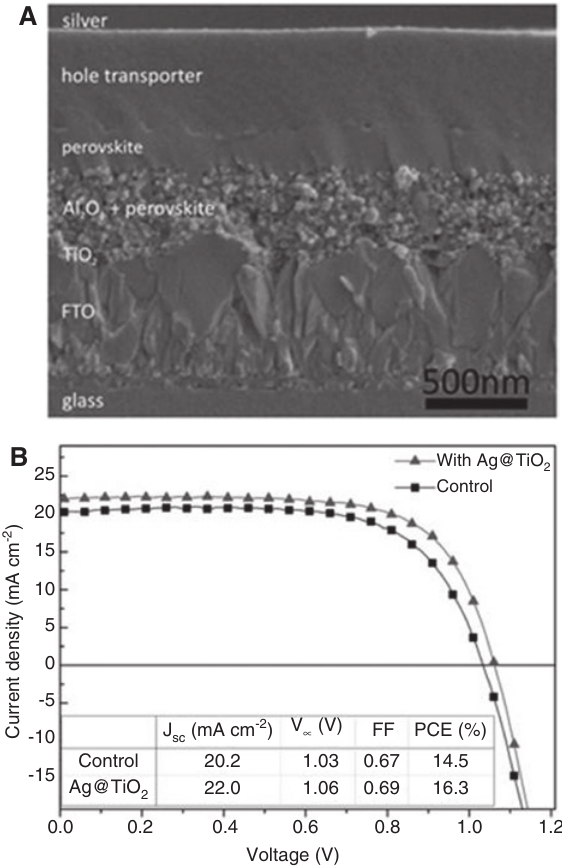
Figure 23: (A) SEM cross-section of a meso-superstructured solar cell (MSSC), (B) current density-voltage characteristics for the best control device and optimized Ag@TiO device. The solar cells were 2 measured via scanning from 1.4 V to short circuit at a scan rate